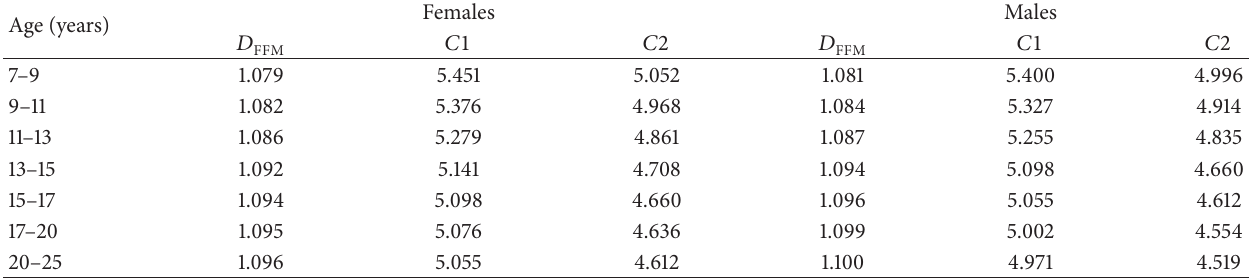
Table 1: Age- and sex-specific constants for conversion of body density, water, and mineral to %FM in children and youth. Age (years)